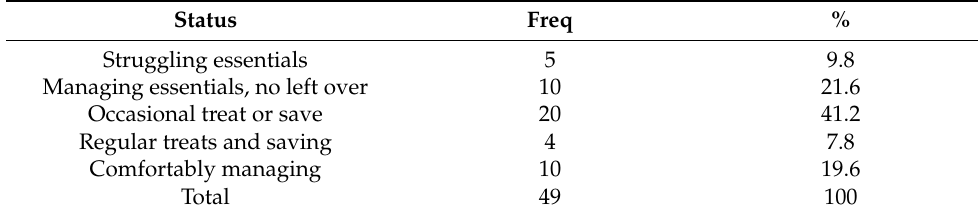
Table 2. Socioeconomical status of participants in this